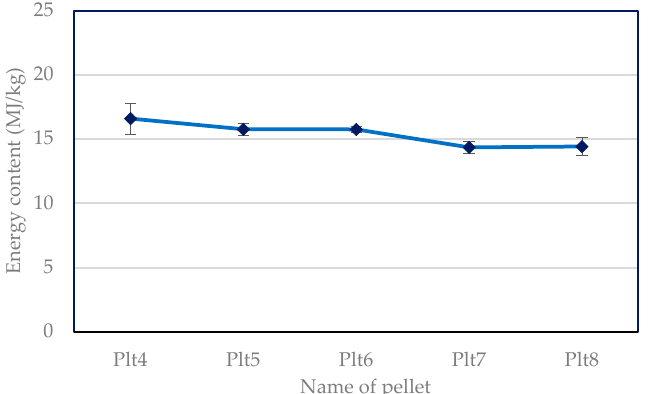
Figure 9. Comparison of the energy content of pellets composed of seaweed and wood chips.